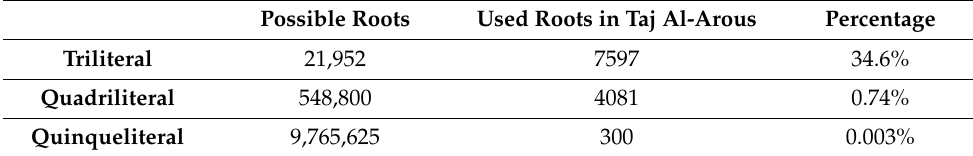
Table 2. Letters Combinations